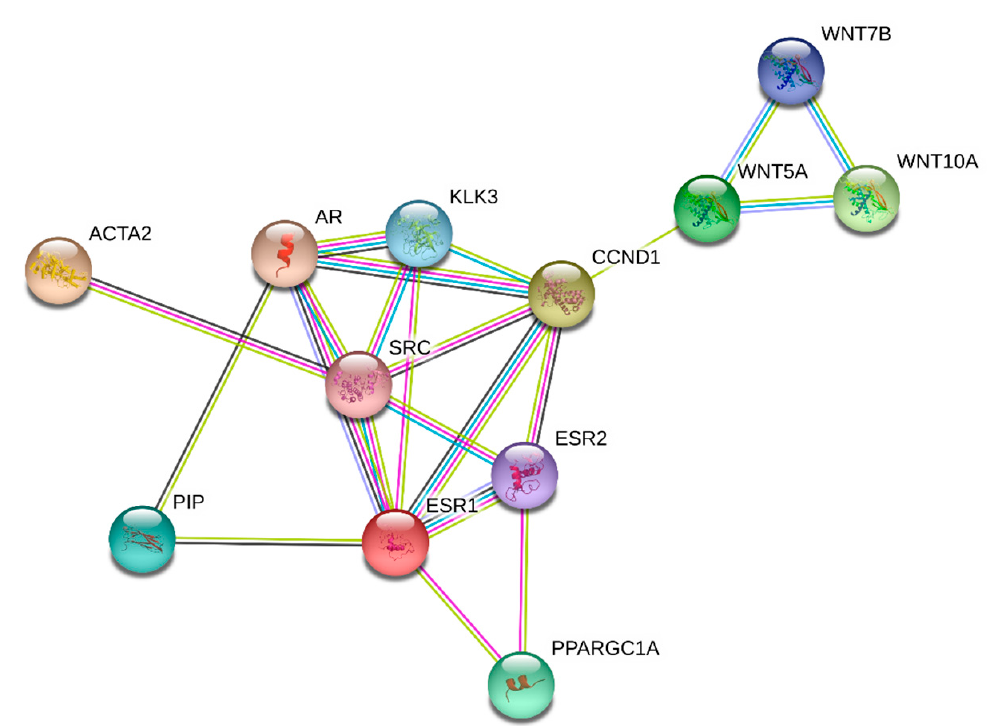
Figure 1. STRING analysis displaying WNT5A, WNT7B, WNT10A, CCND1, ESR1, ESR2, PPARGC1A, SRC, PIP, KLK3, AR, and ACTA2 protein associations.